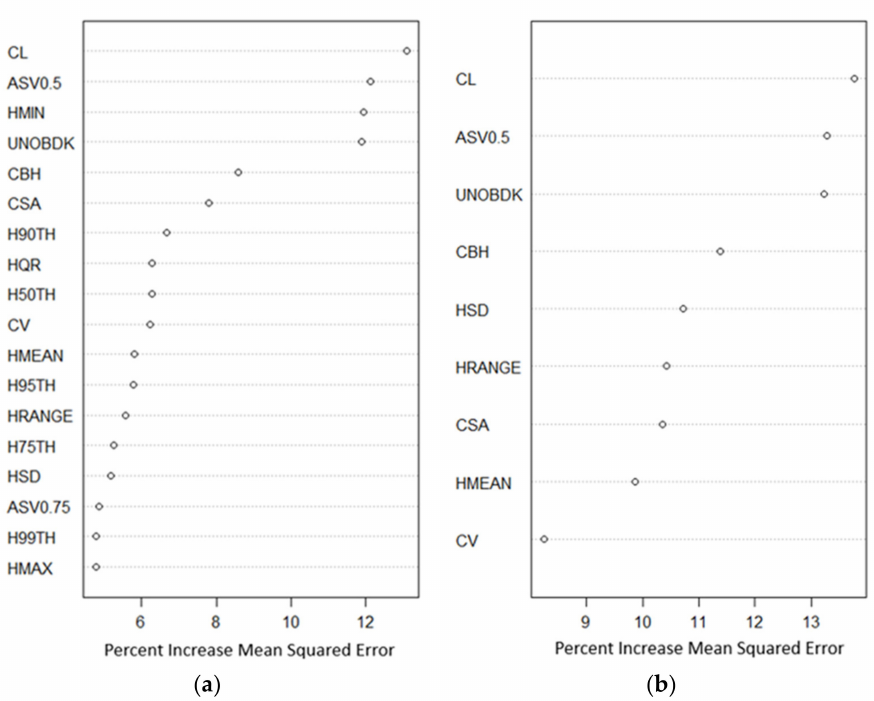
Figure 5. ( a ) Variable importance plot indicating the percent increase in mean squared error when each variable is removed from the model; ( b ) variable importance plot without